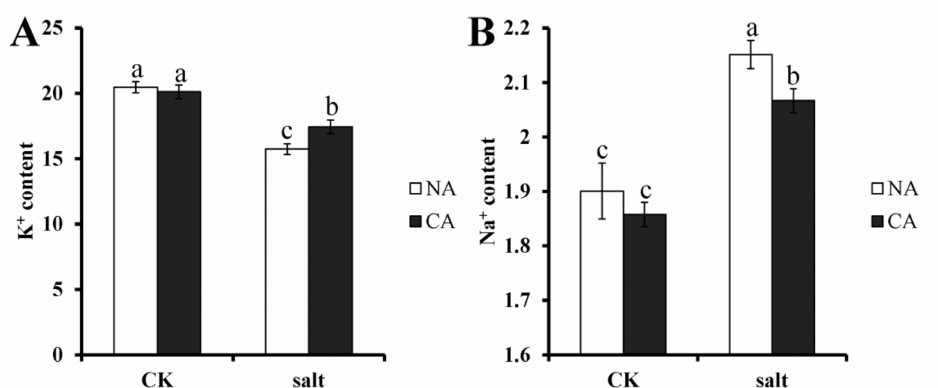
Figure 2. Ion content in bermudagrass under di ff erent treatments. ( A ). K + content; ( B ). Na + content. Mean values and standard deviation (SD) were calculated from three independent experiments. Di ff erent letters indicated significant di ff erence ( p < 0.05) based on one-way analysis of variance (ANOVA), Duncan’s multiple range test. Bars show SD. CK = control; NA = non-cold treatment; CA = pre-cold treatment for 6 h.